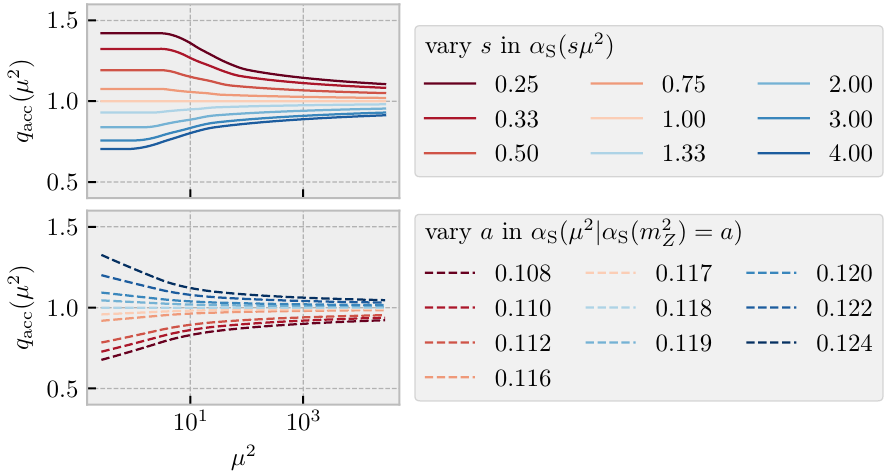
Figure 2 . Display of the (cid:11) S variations used for validating the neural network approach. The upper row shows the scale variations, whereas the lower row shows variations of the input value (cid:11) S ( m 2 The q acc function values as shown on the left are the input for the neural nets, as explained in section